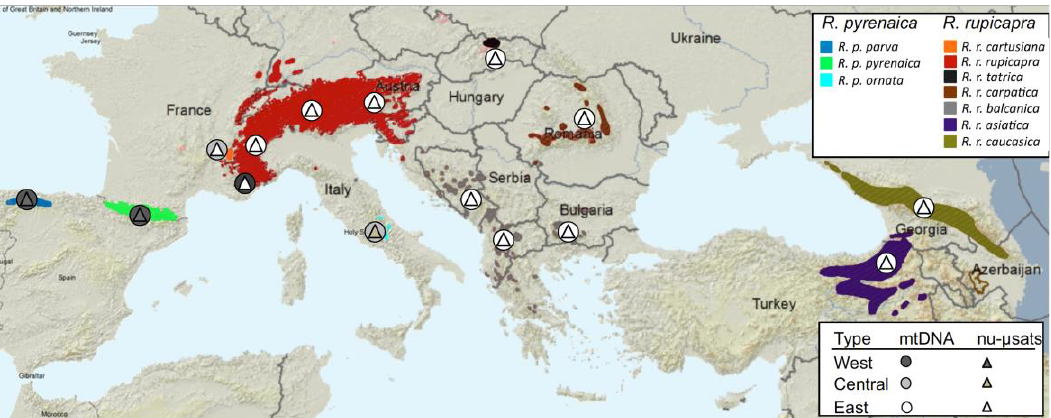
Figure 1. Geographic distribution of the subspecies of the genus Rupicapra . The map was modified from the distribution map on the IUCN Red List [16]. The affiliation to Clades West, Central, and East of extant populations of chamois for the mtDNA and nuclear markers (microsatellites and introns) is represented by forms colored in black, grey, and white,